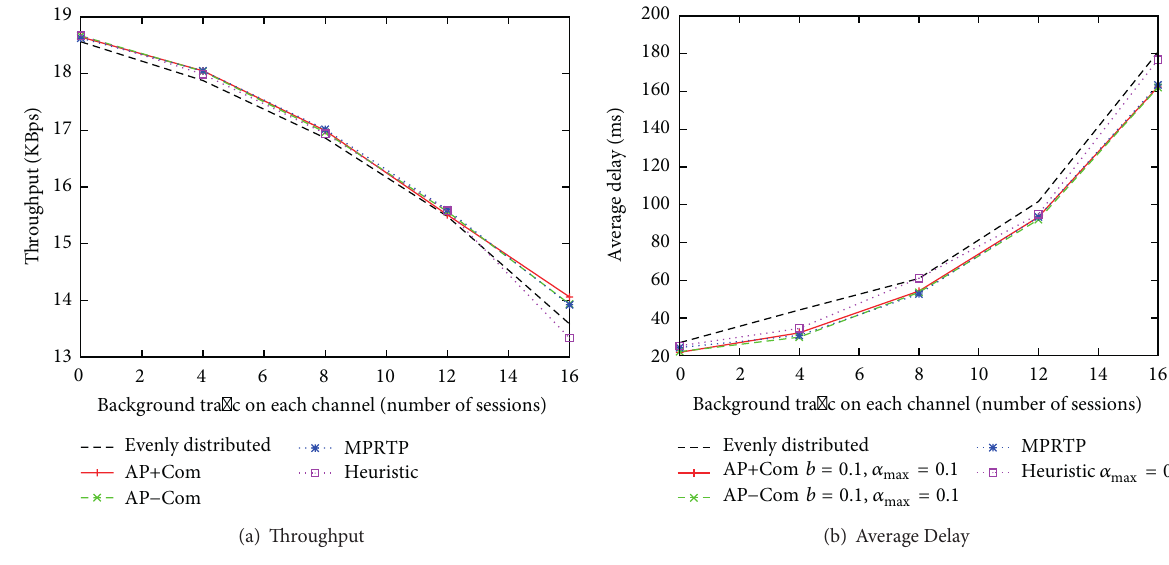
Figure 5: Performance comparison under mobility